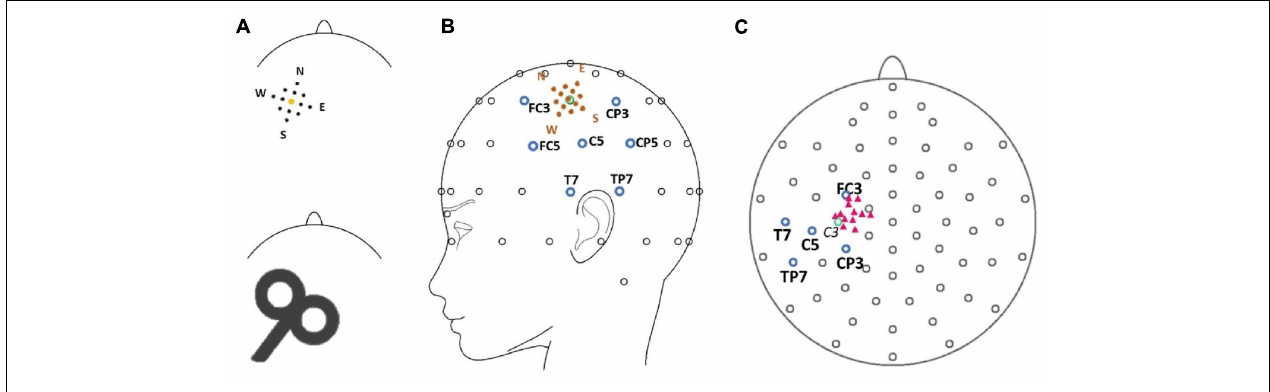
FIGURE 1 | (A) Model of the mapping grid with the corners of the grid named after cardinal points (North, East, South, West) (upper row) as well as a scheme of the stimulation coil (lower row) pictured with the approximate alignment in relation to the shape of the head (view is from the top of the head with the nose pointing upward). Sizes are not true to scale. (B) The position of the grid (orange dots) is illustrated in spatial relation to the electrode montage. Blue circles mark the electrode in the center of the topographical maximum (C5) and neighboring electrodes (FC3, CP3, TP7, T7, CP5, FC5). The green circle marks the position of electrode C3. (C) Pink triangles mark the approximate positions of the individual target muscle motor hot spots during the experimental procedure in relation to the 10–20 electrode system of the 12 participants. The green circle marks the position of electrode C3. Note that the projection (top view) distorts the distances between